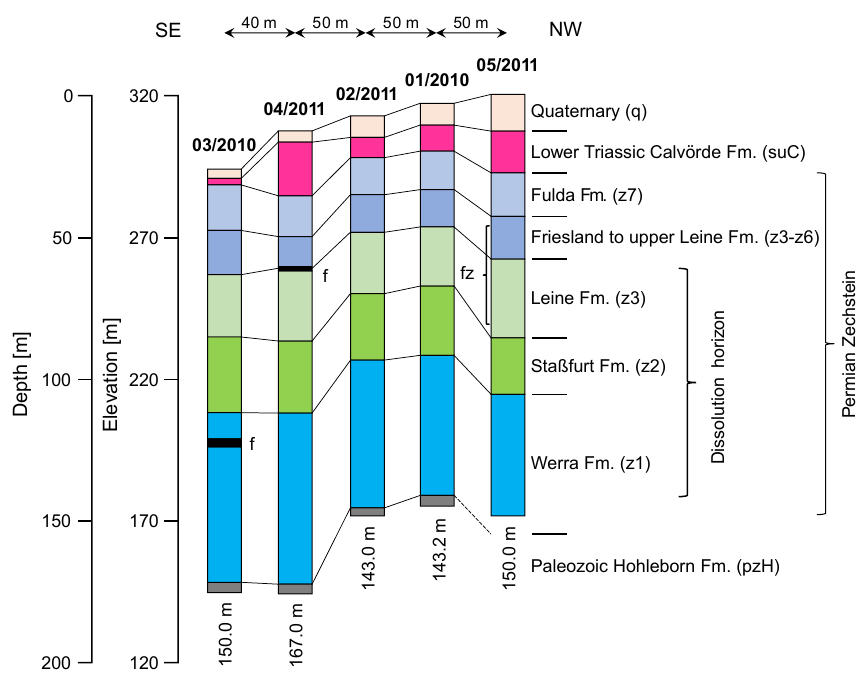
Figure 3. Stratigraphy of the five boreholes (TLUG; personal communication, 2017) near the sinkhole (f is fault, fz is fault zone). The numbers below the profiles show the final depth below surface of each borehole. The stratigraphic units were used for the interpretation of the seismic